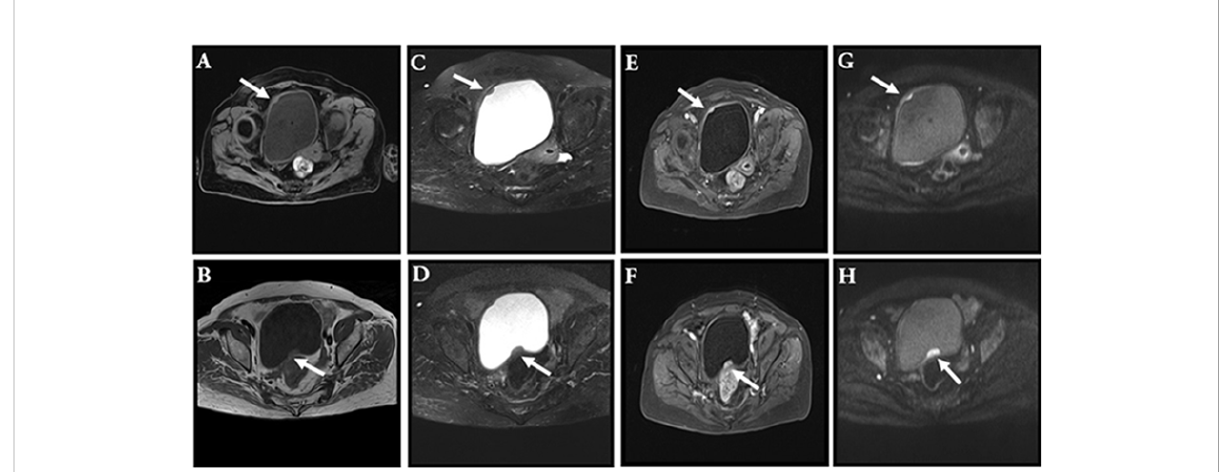
FIGURE 2 MRI. This image showed a space-occupying lesion with long T1 signal in the right anterior wall of the bladder [ (A) , arrow]; this image showed a space-occupying lesion with short T2 signal in the right anterior wall of the bladder [ (C) , arrow]; the enhancement scanning was even [ (E) , arrow]; diffusion was limited [ (G) , arrow]. This image showed a space-occupying lesion with long T1 signal in the posterior upper wall of the bladder [ (B) , arrow]; this image showed a space-occupying lesion with short T2 signal in the posterior upper wall of the bladder [ (D) , arrow];